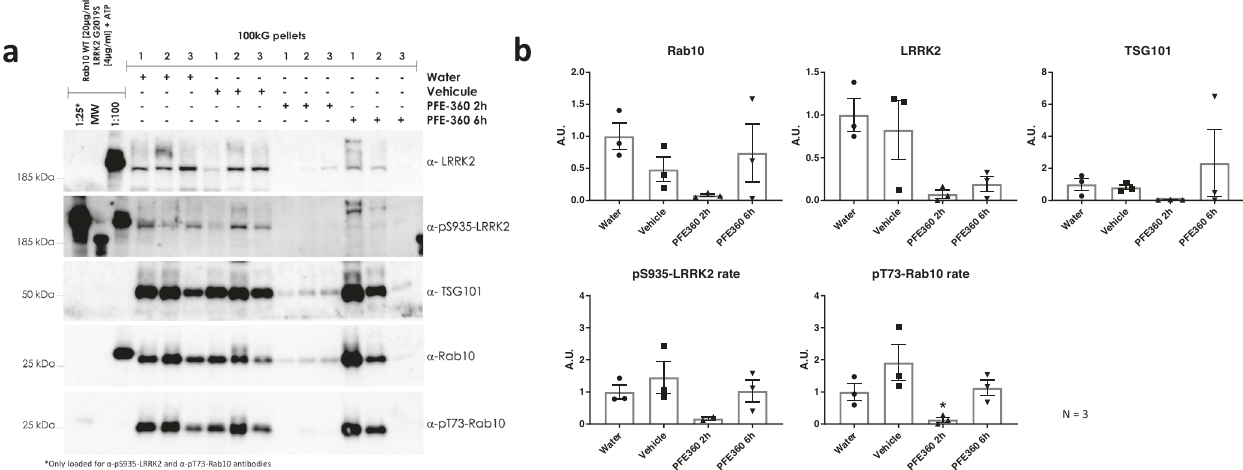
Fig. 6 Effect of acute LRRK2 kinase inhibition on phospho-LRRK2 and phospho-Rab in urinary EVs of macaques. Urine was collected from macaques after different treatments and urinary EVs were isolated as described in materials and methods. a Western blot detection of total LRRK2, pS935-LRRK2, total Rab10, pT73-Rab10, and TSG101 in urinary EVs of NHPs treated with PF360 or solvent (5 mg/kg p.o., 2 and 6 h) (quadruplicate measures per sample). Note that two different dilutions of the calibration standard were used and these are separated by a molecular weight marker containing a band that is detected by the anti-pS935-LRRK2 antibody. b Quanti fi cation of ( a ). The values of phosphorylation ‘ rate ’ are indicative of the proportion of protein that is phosphorylated at the given site, see materials and methods. Statistical differences were tested using a Kruskal-Wallis test followed by a Dunn ’ s post-hoc test using the vehicle group as control. Note that values for pS935-LRRK2 were below the linear range of quanti fi cation at the 2 h time point and statistical anlaysis was not possible. Error bars represent standard error of the mean (s.e.m.). * P < 0,05 ( N = 3). MW molecular weight